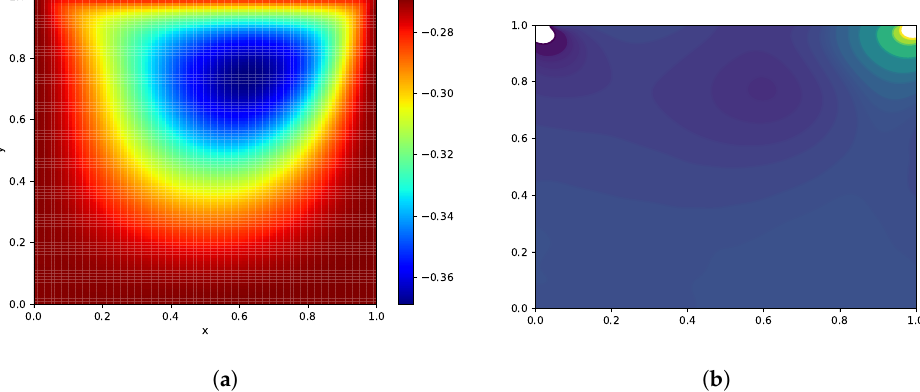
Figure 21. The stream function ψ and pressure field p . ( a ) The stream function ψ . ( b ) Pressure field p